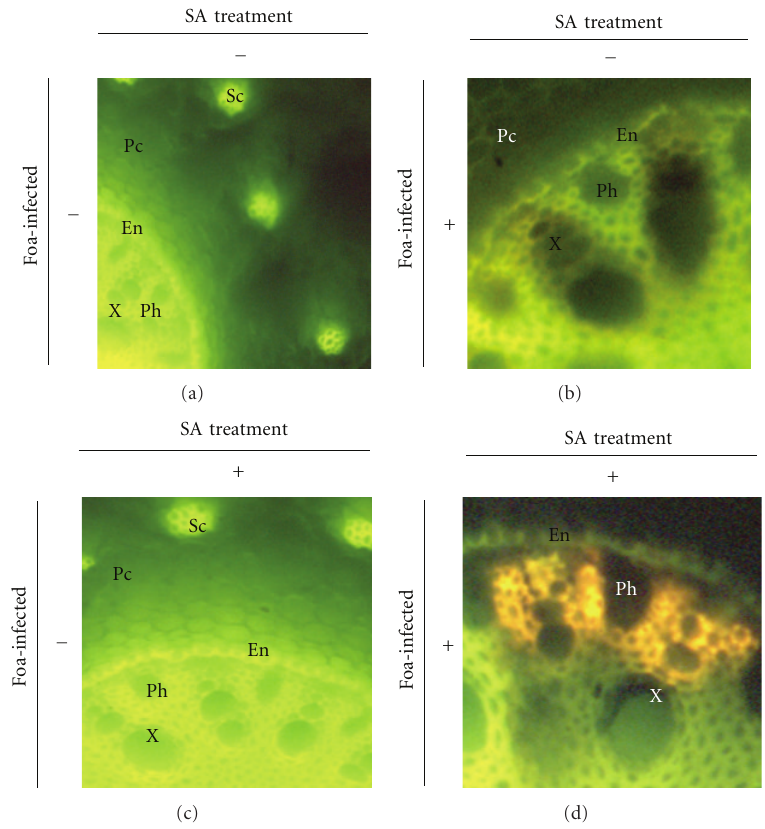
Figure 5: Histochemical localization of ca ff eic acid derivatives and flavonoids in date palm root tissues stained with Neu’s reagent under blue light (green yellow and bright orange, resp.). (a: × 20) Control roots (UU), ca ff eic acid derivatives were observed at sclerenchyma, endodermis, and vascular parenchyma cell walls; (b: × 40) inoculated roots (UI), a dark zone appeared in cells situated near the xylem vessels. (c: × 20) SA treated roots (TU); (d: × 40) SA treated and Fusarium oxysporum f. sp. albedinis- infected roots (TI); note the presence of flavonoids in the vascular-parenchyma cell walls near the xylem vessels. X: xylem vessels; Ph: phloem; En; endodermic cells; Pc: parenchyma cells; Sc: sclerenchyma